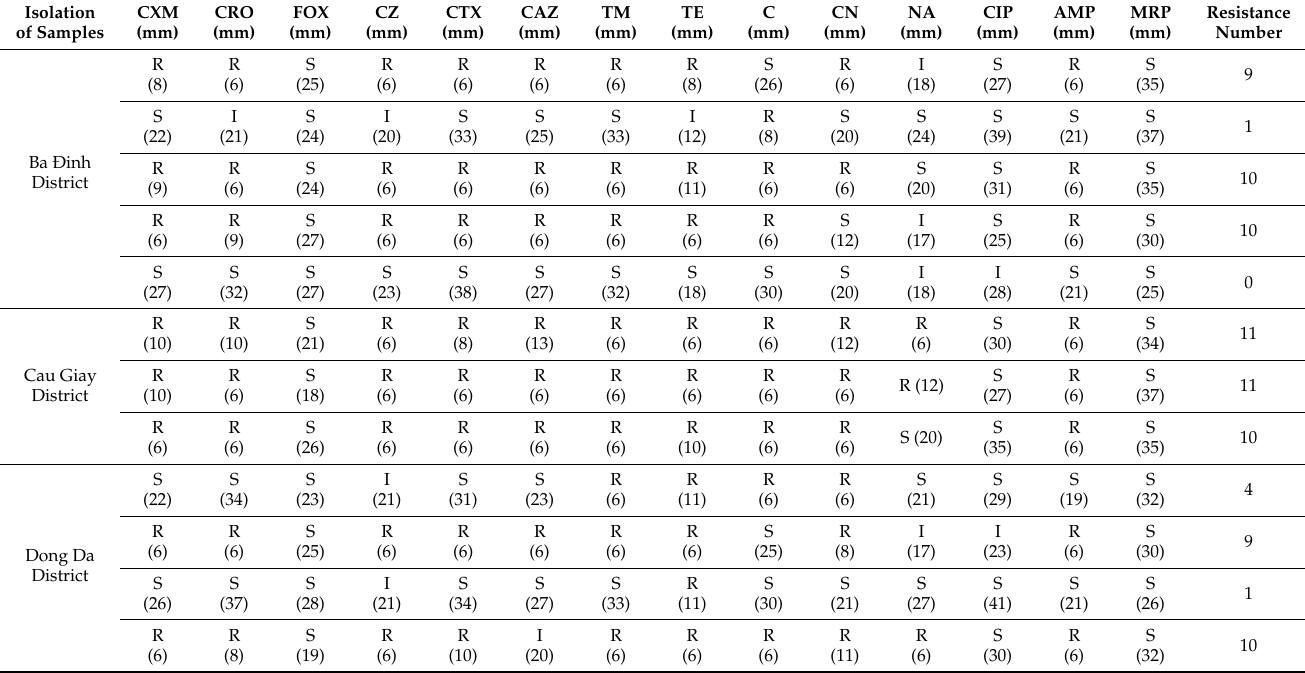
Table A1. Antibiotic resistance profiles of Salmonella isolates (zone of inhibition expressed in